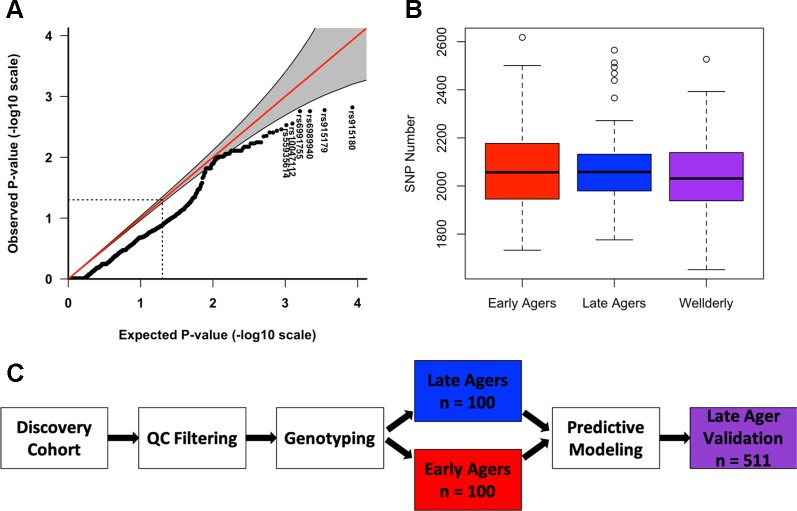
Logistic regression and variant burden reveal lack of association with early aging. (A) Quantile-quantile plot of logistic regression p-values. (B) Box plot of total number of variants in the discovery early aged group (red), discovery late ager group (blue), and the validation late ager group (purple). (C) Diagram of predictive modeling analysis study design.